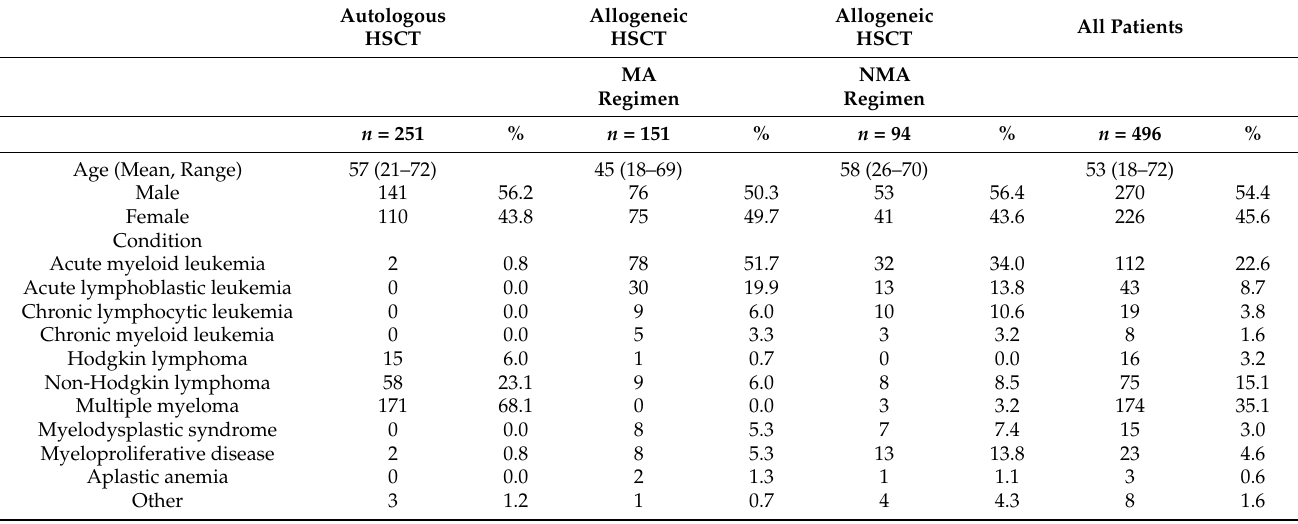
Table 2. Basic characteristics of the